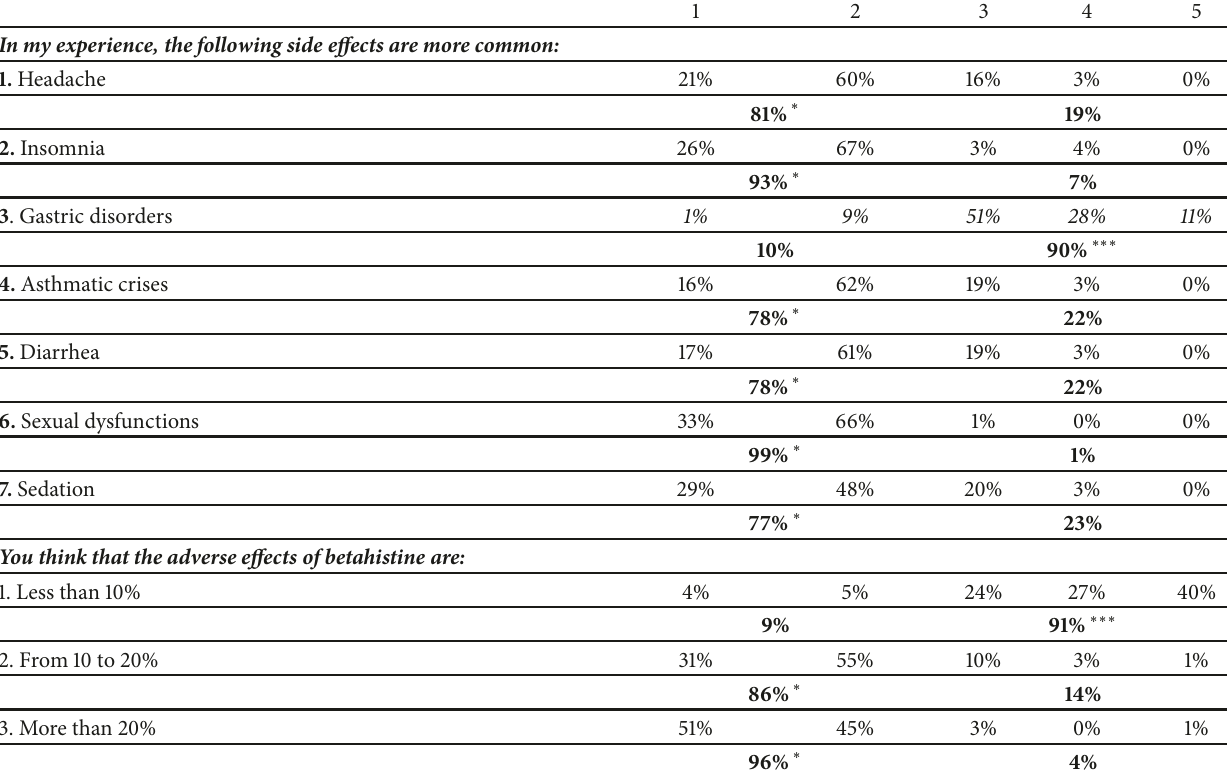
Table 8: Results of the Consensus Conference on the adverse effects, safety, and efficacy of betahistine. 1 = absolutely disagree, 2 = disagree, 3 = agree, 4 = more than agree, and 5 = absolutely agree. Consensus was reached when the sum of items 1 and 2 or 3, 4, and 5 reached 66%. Same asterisk convention.